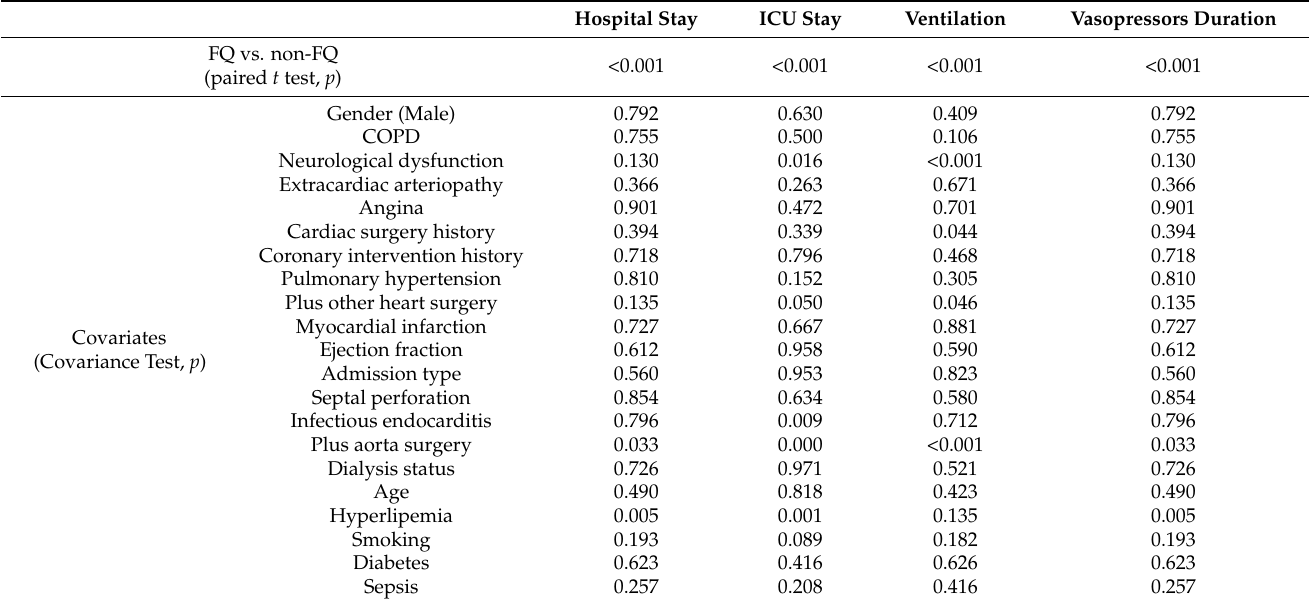
Table 4. Difference and their covariance of hospital stay, ICU stay, ventilation time, and vasopressors duration of the matched cohort.